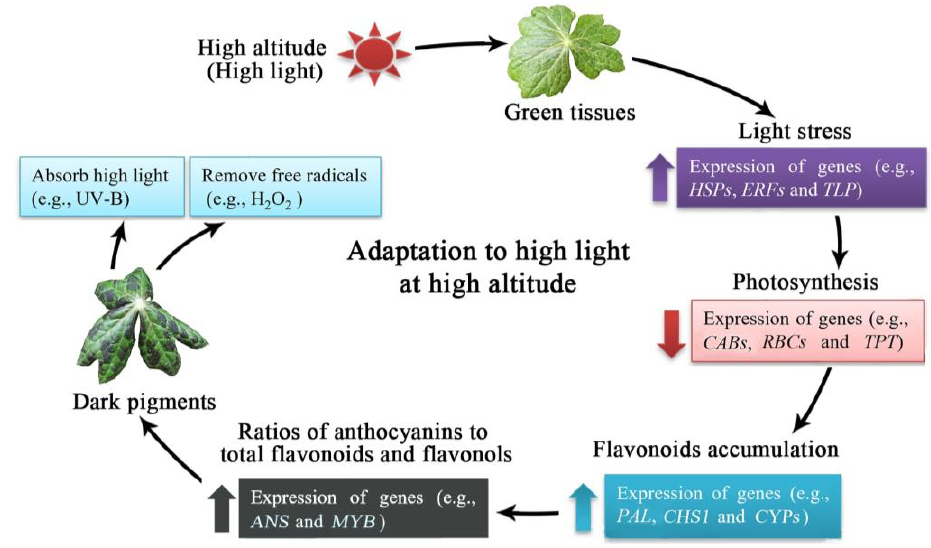
Figure 6. A proposed model of high-altitude-induced flavonoid biosynthesis in Sinopodophyllum hexdanrum adaptation to the high altitude that includes high light intensity.